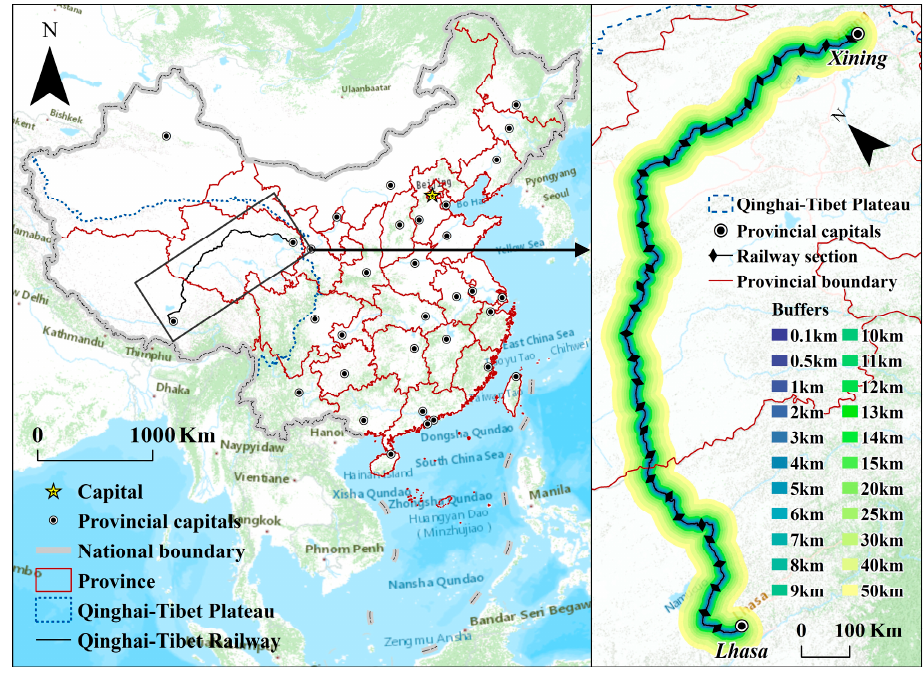
Figure 1. Location and different sections and buffers of QTR.